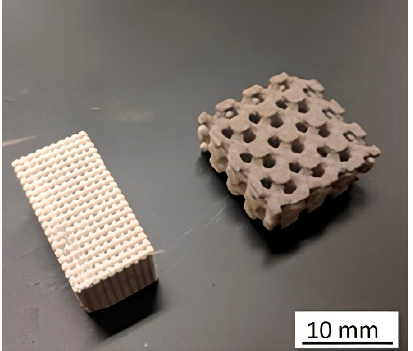
Figure 23. 3D-printed FGP samples with controlled gradient porosity by the BJ technology (Reprinted from Ref. [102], copyright (2019), with the kind permission of IOP Publishing Ltd.).